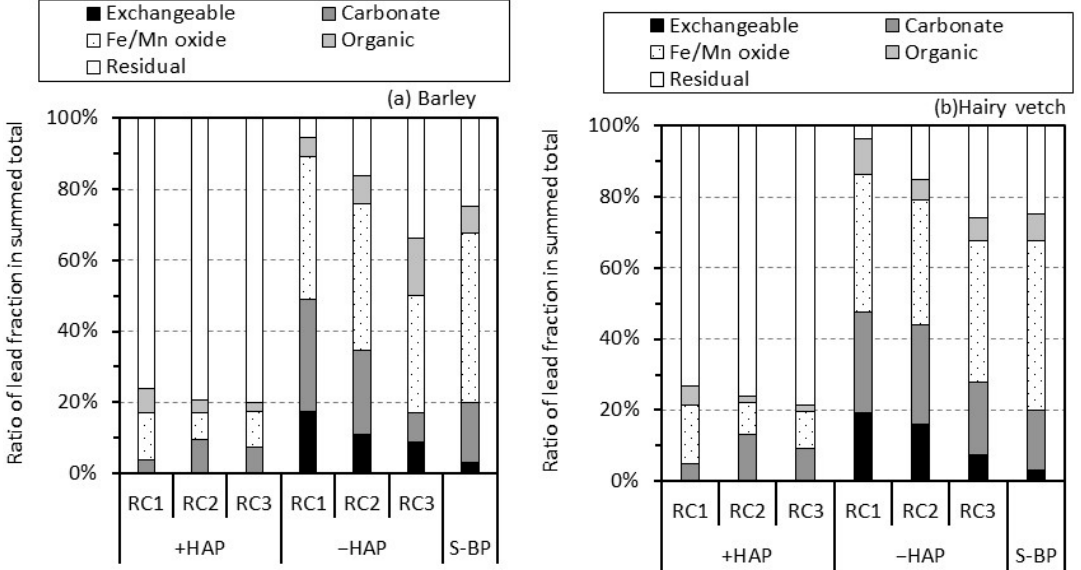
Figure 3. Lead fraction of the sum total by sequential extraction in soil before it was planted (S-BP) and rhizosphere soil (RC1–RC3) with and without hydroxyapatite (+HAP and − HAP, respectively) for ( a ) barley and ( b ) hairy vetch.